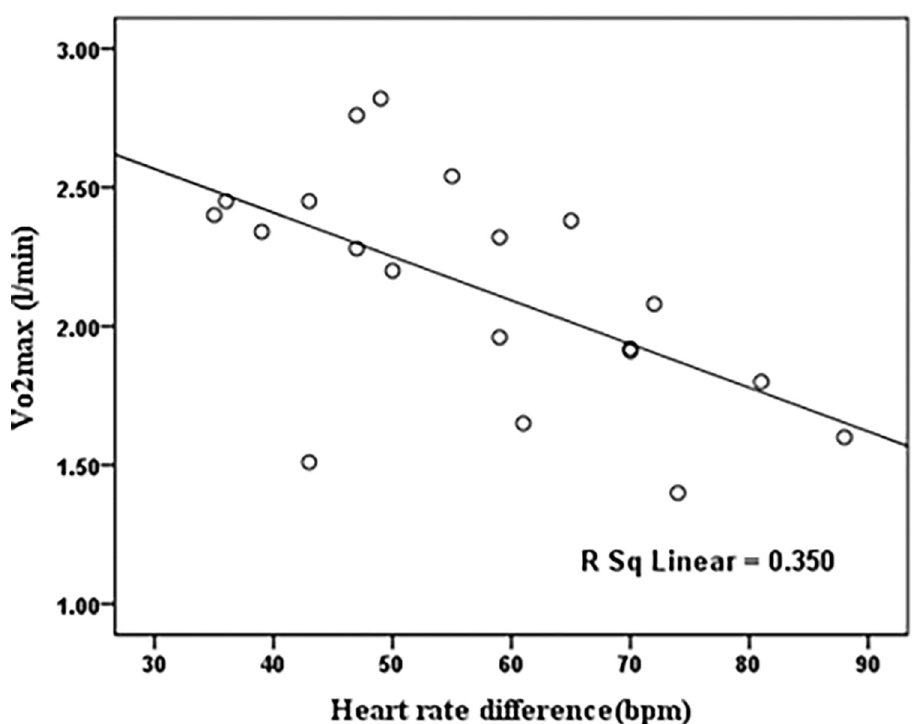
Fig 3. The scatter plots of theVO 2 max compared to heart rate difference before and after walking on a treadmill in the warm air condition.